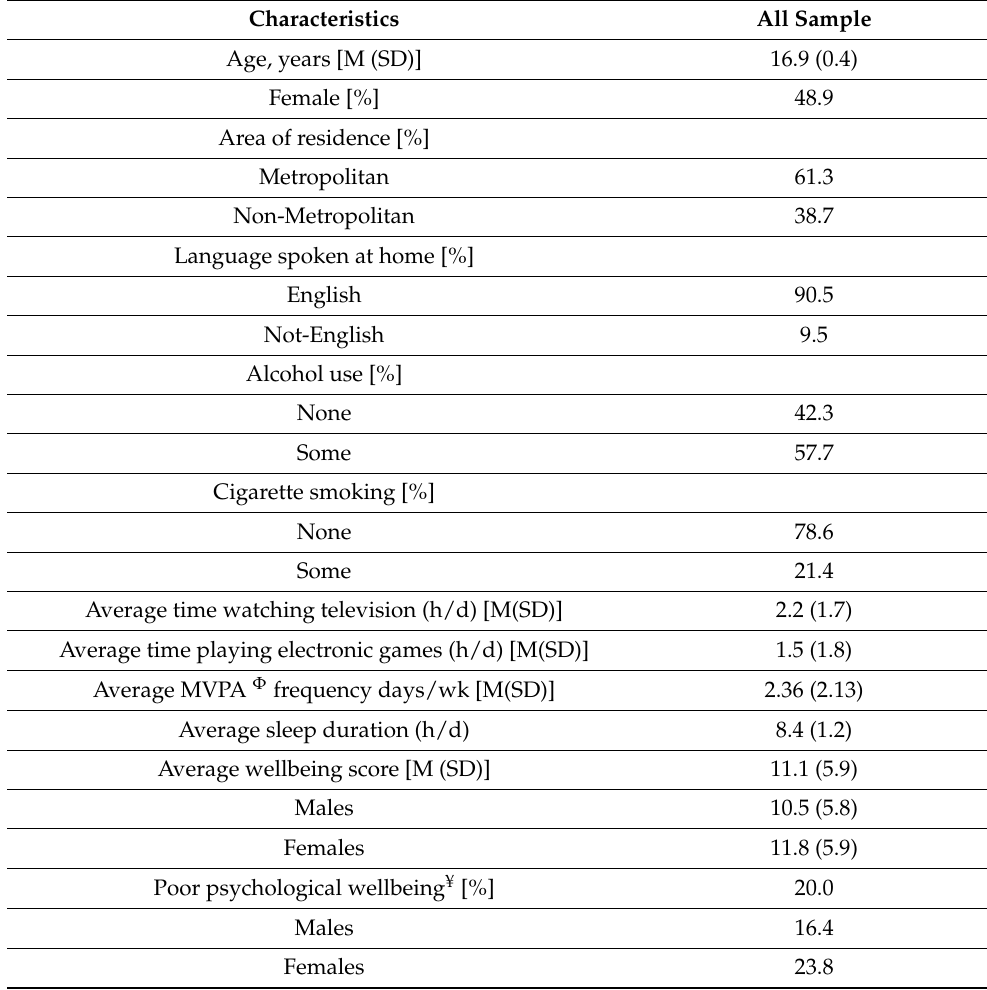
Table 1. Characteristics of the study participants, 2016 ( n =